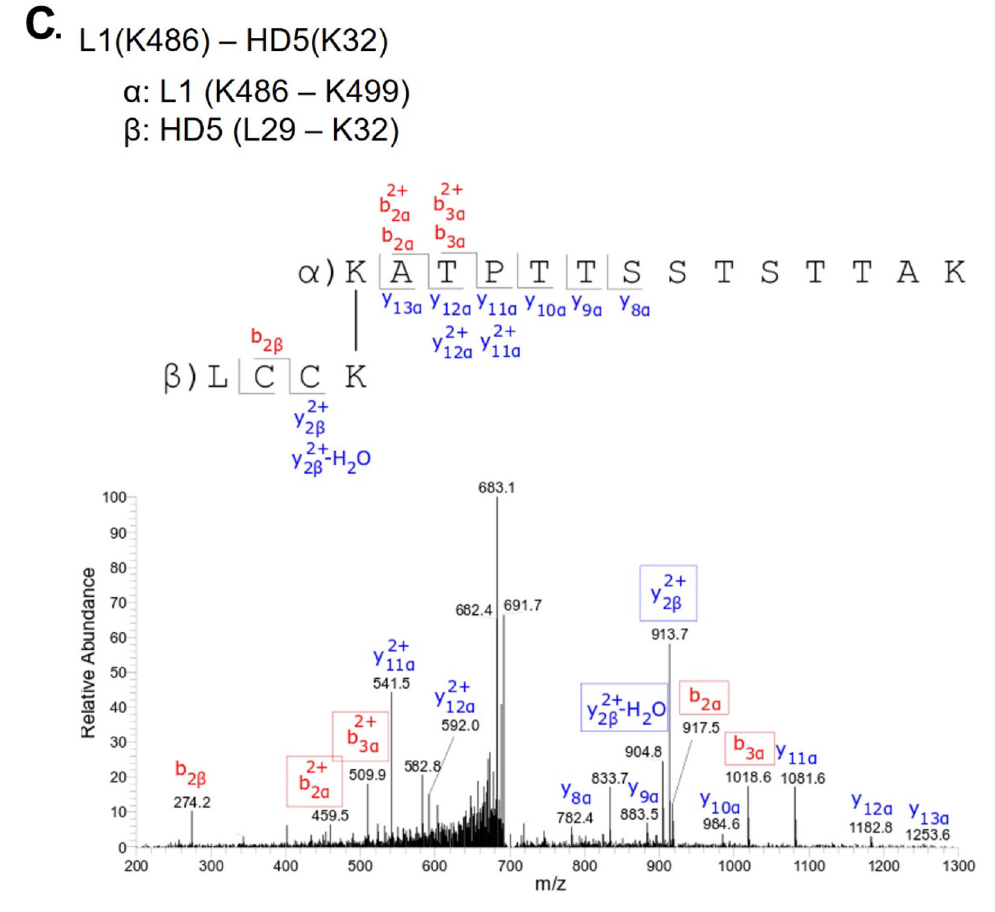
Supplementary Figure 3. Tandem mass spectra of crosslinked peptides identified: Inter-protein cross- links between L1 and HD5-R13K/R32K. Observed b- and y-series ions are shown in each spectrum and the fragment ion species containing the crosslinker plus regions of two crosslinked peptides are boxed. (A) MS/MS spectrum of an inter-protein crosslinked peptide (m/z 427.7, +4 charge) between Lys477 of